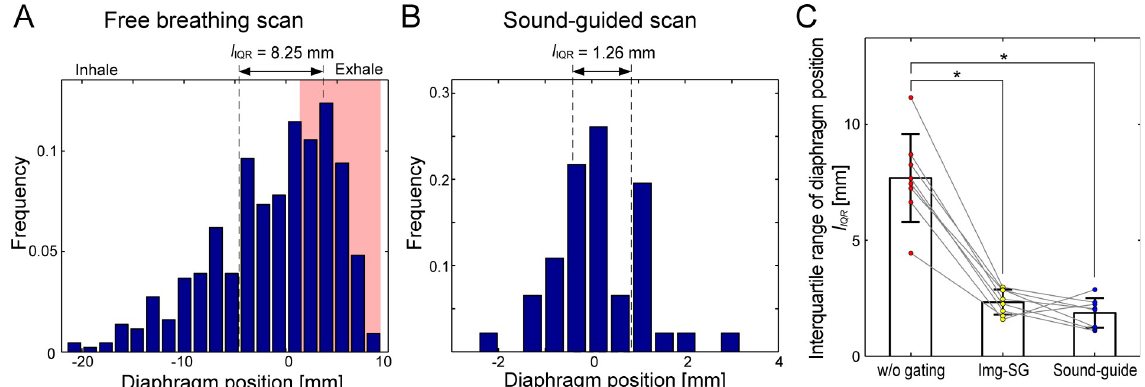
Fig 4. Frequency histogram of the diaphragm positions during free-breathing and sound-guided UTE MRI scans. A) Interquartile range of the diaphragm positions under free-breathing, l IQR , was 8.25 mm. By extracting data at the highest 40% diaphragm positions for image- based self-gating (Img-SG; red area), l IQR was reduced to 2.87 mm. B) l during the sound-guided scan (Sound-guide) was 1.26 mm, which IQR indicates the sound-guided respiration facilitated a similar diaphragm position in every breath. C) The reduction of l IQR with Img-SG (2.34 ± 0.54 mm) and Sound-guide (1.88 ± 0.64 mm) as compared to free-breathing (w/o gating, l = 7.69 ± 1.90 mm) was statistically IQR significant ( p = 0.0003 and 0.0005 for Img-SG and Sound-guide, respectively). The difference of l IQR between Img-SG and Sound-guide was not significant ( p = 0.68). � represents p < 0.05/3 = 0.0167 with the Bonferroni correction for multiple comparison. Colored points represents l IQR for individual subjects ( N = 8). The data shown in A and B is from the same subject as the one in Figs 2 and 3.